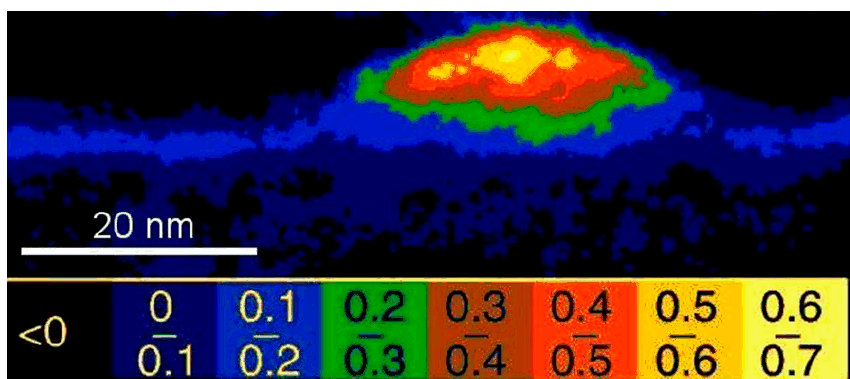
Figure 3. Example of uncapped epitaxial InGaAs quantum dot imaged by energy-filtered TEM (EFTEM) using both In M and Ga L edges. Indium enrichment in the centre is due to lateral segregation during growth. Reproduced from [15], with permission from American Physical Society, 4 June 2019.